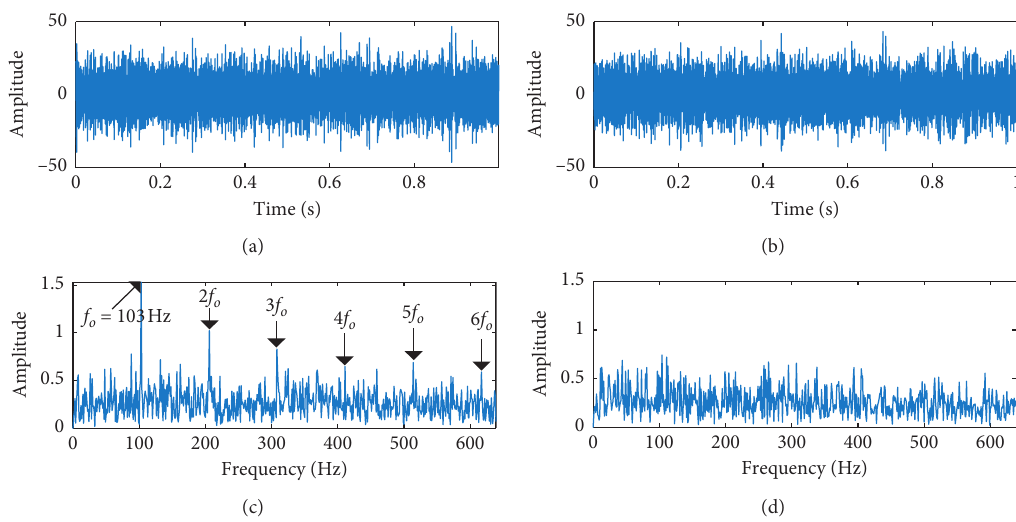
Figure 17: Results of the experimental data in Figure 14(a) by different ICF locating methods: (a) optimal mode extracted by the proposed method and (c) its envelope spectrum; (b) optimal mode extracted based on EFS and (d) its envelope